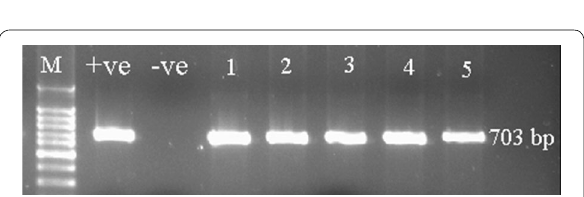
Fig. 2 PCR product of 703 bp amplified with primers A2, J5 on 1.5%